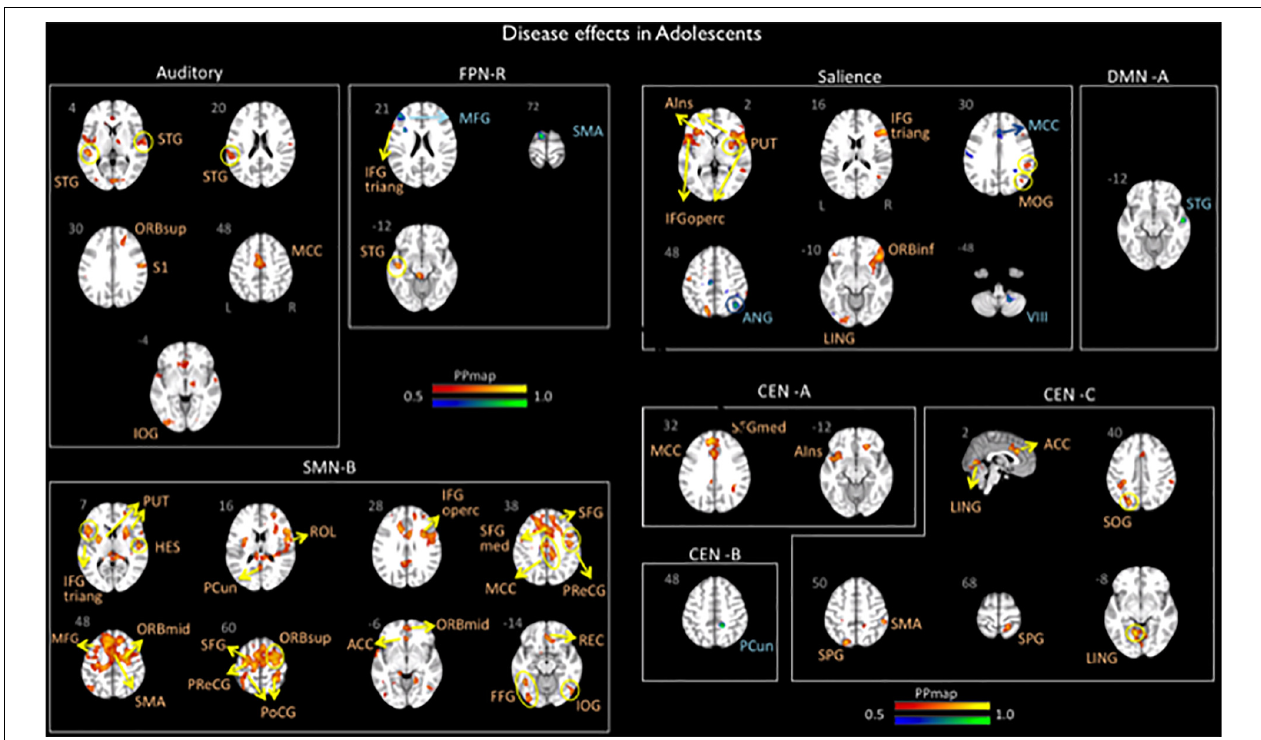
FIGURE 2 | Disease effects on rs-FC networks in the adolescents group vs. healthy controls. The figure summarizes the statistically significant changes in connectivity measured between adolescent migraineurs and their healthy controls. Changes were found in the auditory, frontal parietal right, sensorimotor B, salience, default mode A, and central executive A, B, and C networks. See text for further details and Table 4 . Numbers refer to the standard MNI Atlas coordinates. Abbreviations of brain regions are described in Table 8 . Red – Yellow: Increased connectivity in adolescent migraineurs vs. controls. Blue – Green: Decreased connectivity in adolescent migraineurs vs.